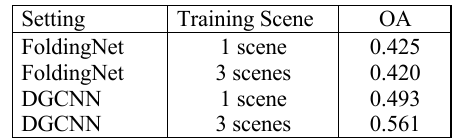
Table 3 . The varying encoders tested on ArCH Data Set